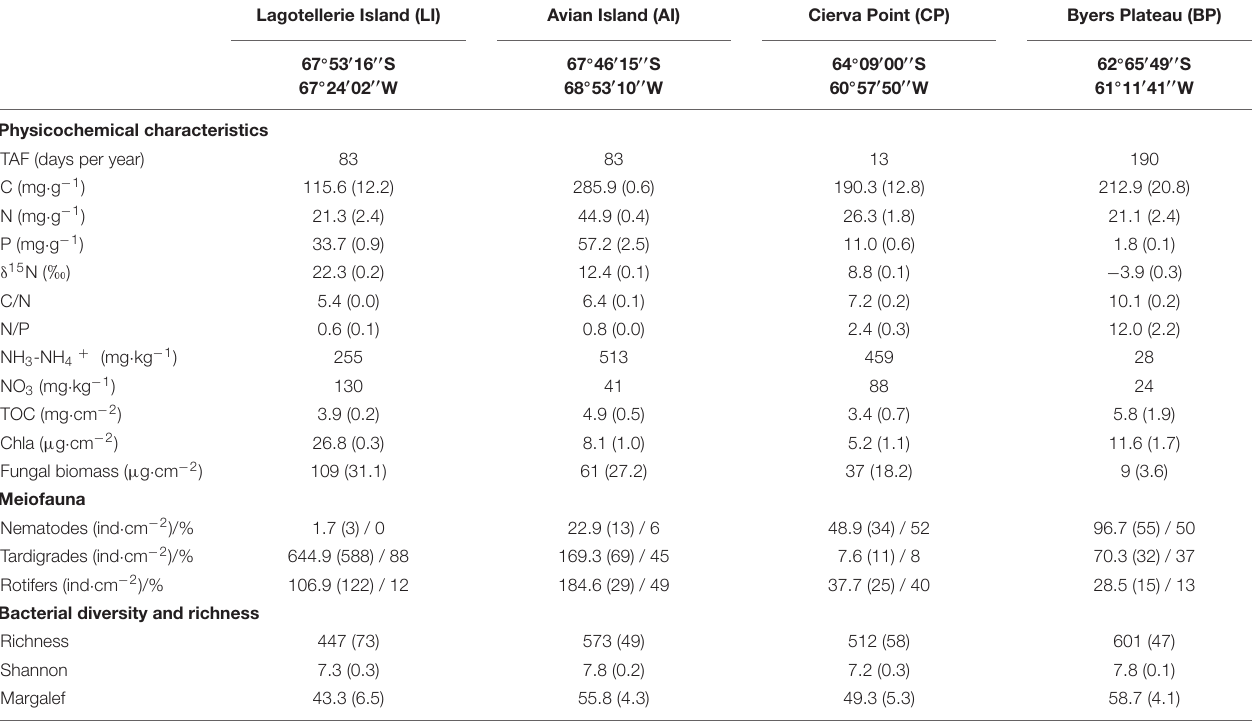
TABLE 1 | Mean (standard deviation in parentheses) values of the physicochemical characteristics of the four microbial mats included in this study. Lagotellerie Island (LI) Avian Island (AI) Cierva Point